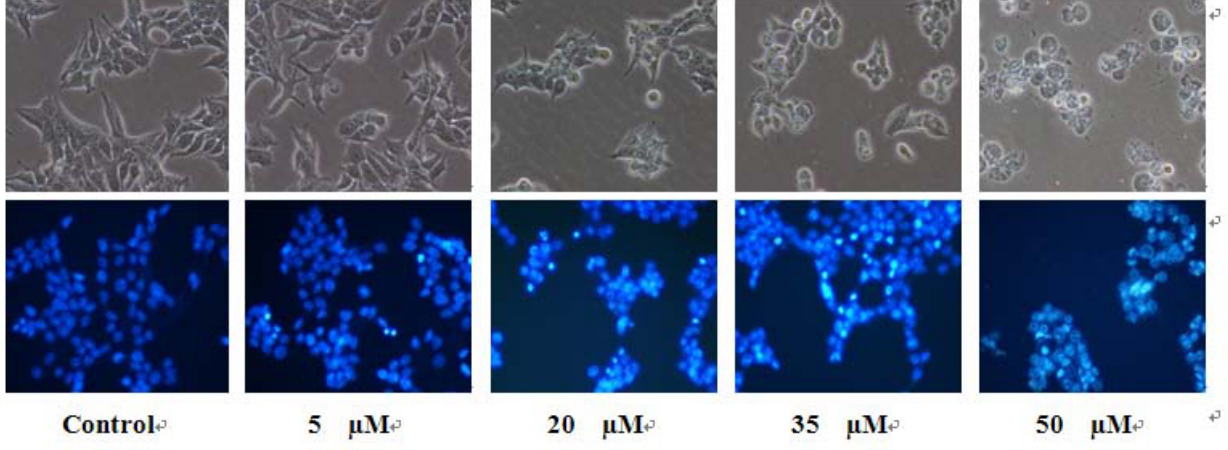
Figure 7. Morphological changes of MCF-7 cells observed under an inverted phase contrast microscope